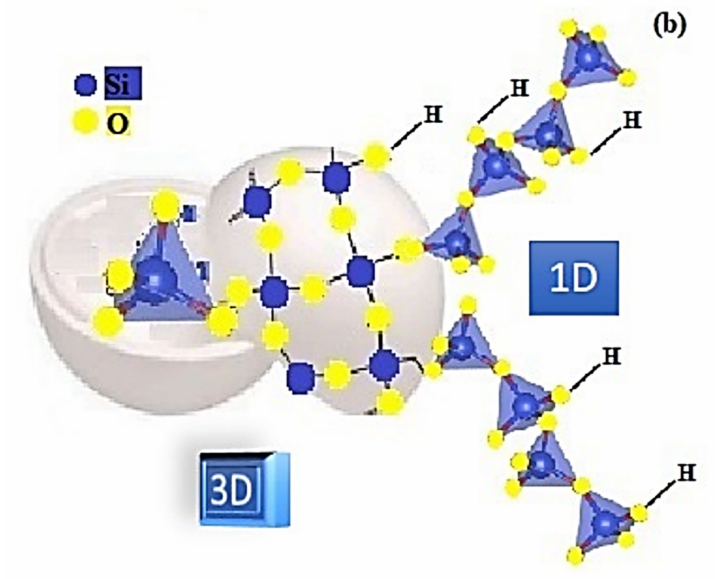
Figure 11. The proposed simplified schematic illustrations showing the surface functionalization of SiO 2 , ( a ) before treatment, ( b ) after